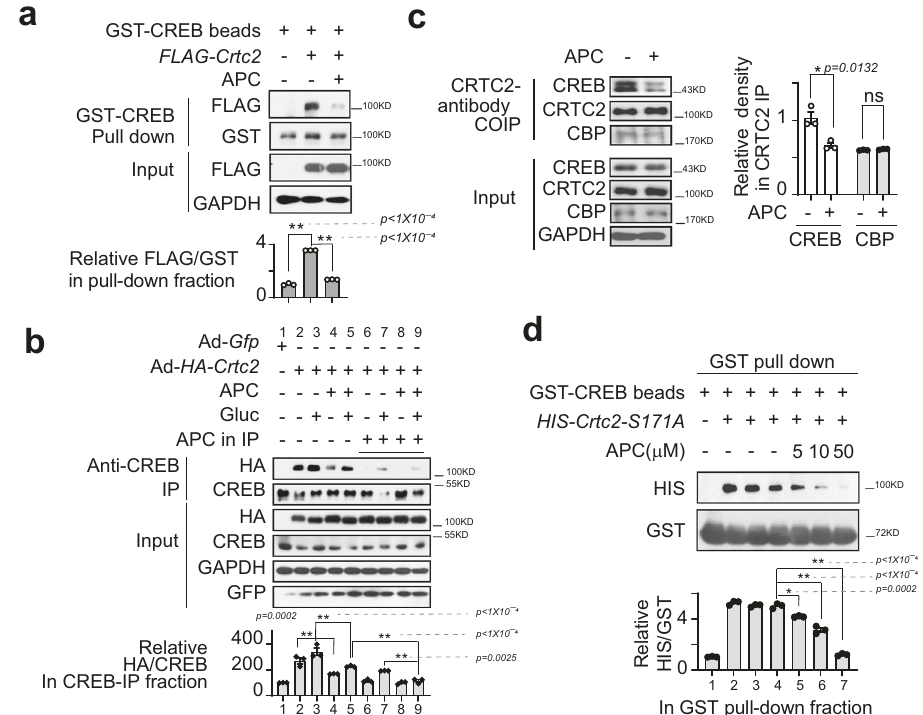
Fig. 2 APC blocks interaction between CREB and CRTC2. a Analysis of GST-CREB immunoprecipitated with overexpressed FLAG-CRTC2 from the lysates of HEK293T cells. APC (10 μ M) was added to the culture media for 1 h and the following IP mixture. The relative gray density of FLAG in GST-pull-down fraction is shown as a bar graph (bottom). One of three independent experiments is presented (top, n = 3). Data are represented as mean ± SEM); P values were determined by one-way ANOVA followed Dunnett ’ s multiple comparisons test. b Analysis of HA-CRTC2 immunoprecipitated with endogenous CREB from primary hepatocyte lysates. APC (10 μ M) was added to the culture media for 1-h before 30-min of stimulation with glucagon (Gluc, 100 nM) and the following IP mixture as indicated. Top panel presents one of three independent experiments, and the relative gray density of HA in CREB-IP-faction is shown as a bar graph (bottom, n = 3). Data are represented as mean ± SEM; P values were determined by one-way ANOVA followed Dunnett ’ s multiple comparisons test. c Immunoblotting analysis of endogenous CREB, CRTC2, and CBP interaction by an anti-CRTC2 antibody from the lysate of primary hepatocytes. APC (10 μ M) was added to the culture media for 1-h before 30-min stimulation with glucagon. Related CREB and CBP normalized by CRTC2, respectively, in CRTC2-IP fractions. The top panel presents one of three independent experiments, and the relative gray density of CREB and CBP normalized to CRTC2 in the CRTC2-IP-faction is shown as a bar graph (bottom, n = 3). Data are represented as mean ± SEM; P values were determined by two-way ANOVA followed Bonferroni ’ s multiple comparisons test. d Immunoblotting analysis of protein GST-CREB recovered HIS-CRTC2-S171A proteins puri fi ed from E. coli . The addition of APC (5, 10, or 50 μ M) in pull-down mixtures is indicated. The top part presents one of three independent experiments, and the relative gray density of HIS normalized to GST in GST-pull-down faction is shown as a bar graph (bottom, n = 3). Data are represented as mean ± SEM; P values were determined by one-way ANOVA followed Dunnett ’ s multiple comparisons test (compared with APC =